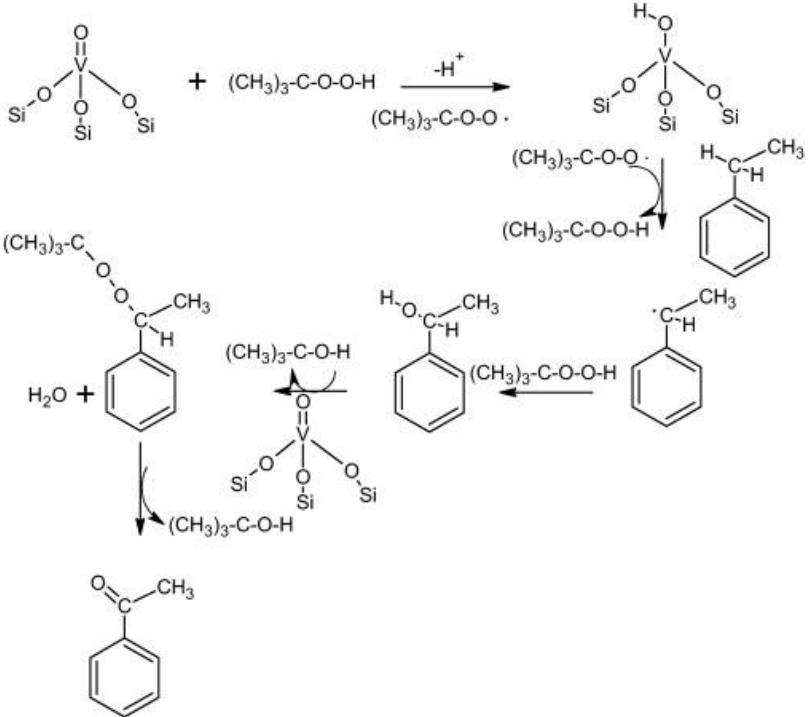
Figure 17. Plausible reaction mechanism for the selective oxidation of ethylbenzene to acetophenone over V-SBA-16 mesoporous molecular sieves. Reprinted from Ref. [142], Copyright 2011, with permission from Elsevier.